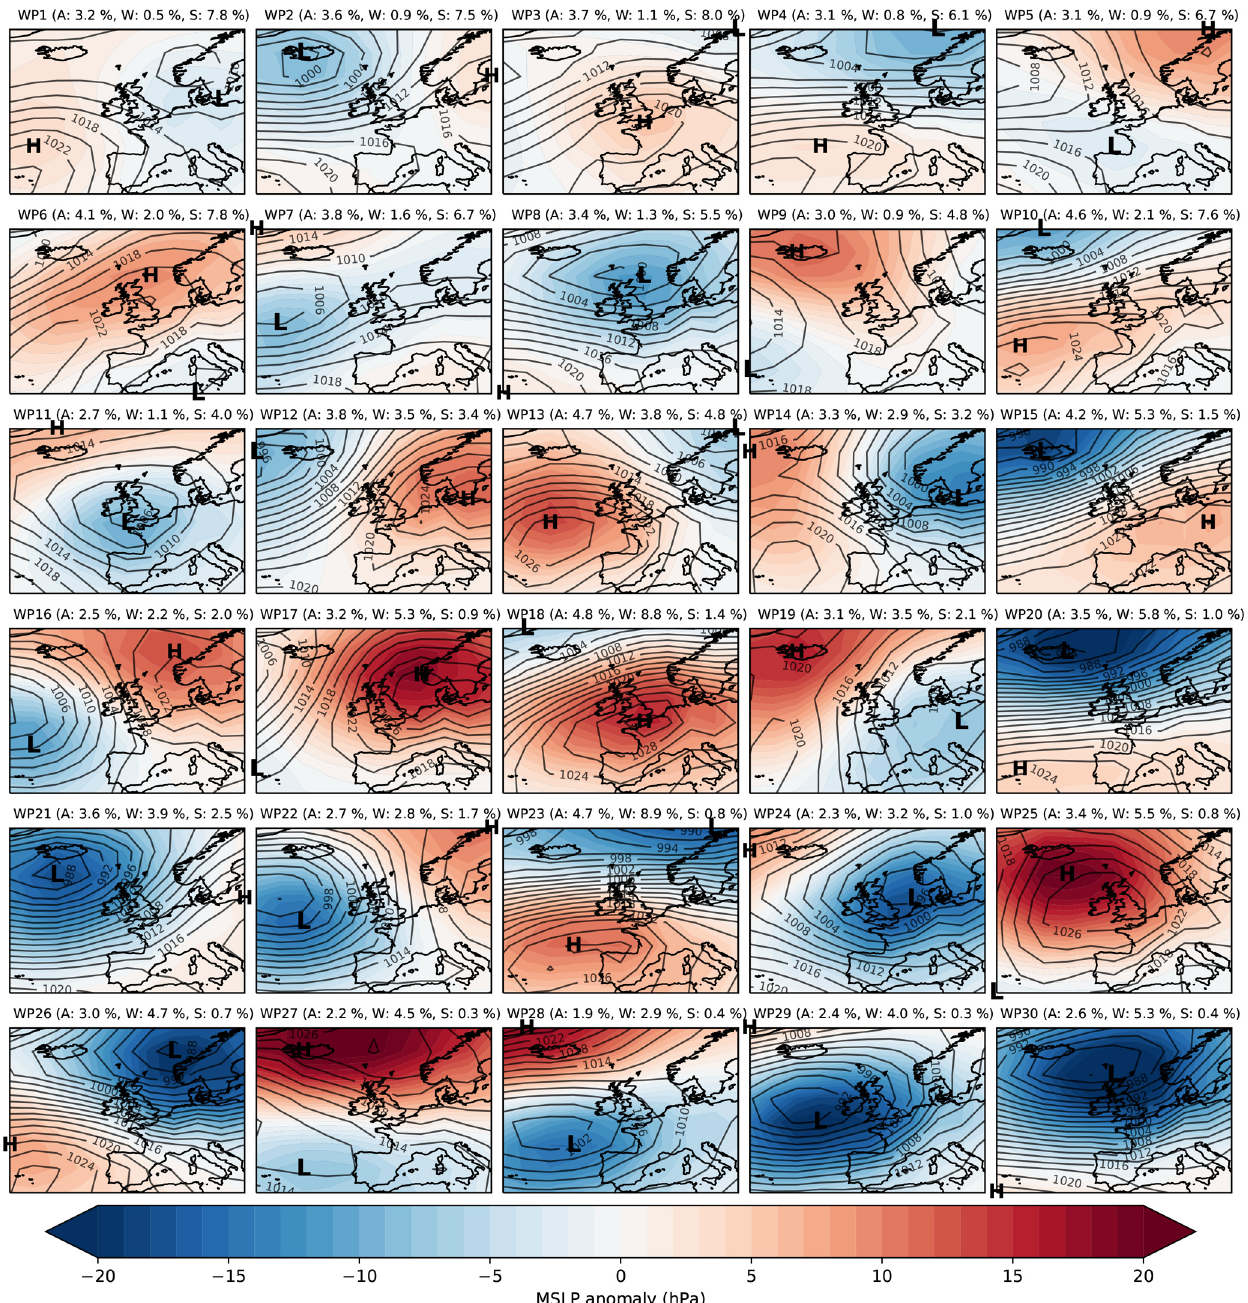
Figure 1. Weather pattern (WP) definitions according to mean sea-level pressure (MSLP) anomalies (hPa). The black contours are isobars showing the absolute MSLP values associated with each weather pattern, with the centres of high and low pressure also indicated. Next to the WP labels are the annual (A), winter (W; DJF) and summer (S; JJA) relative frequencies of occurrences of each WP (%). The frequency- of-occurrence data are associated with the WPs based on ERA-Interim between 1979 and 2017, while the WP definitions were generated from a clustering process applied to EMULATE MSLP reanalysis data between 1850 and 2003. See the text for